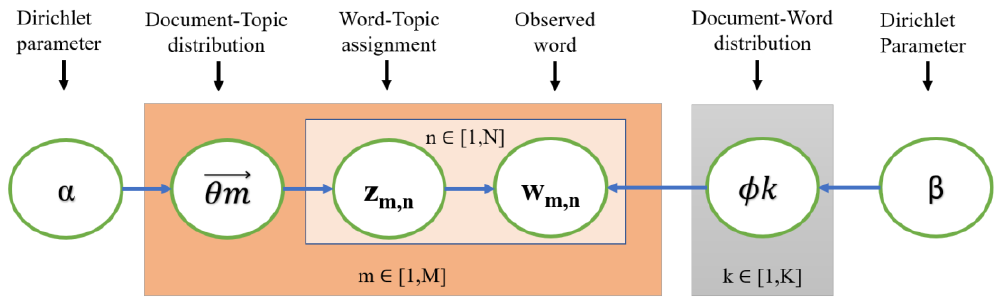
Figure 1. Latent Dirichlet allocation (LDA) model.